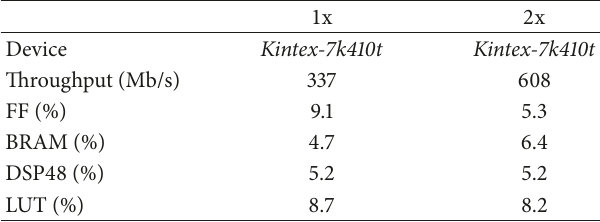
Table 7: LDPC decoder IP FPGA resource utilization and through- put after mapping onto the Xilinx Kintex-7 FPGA